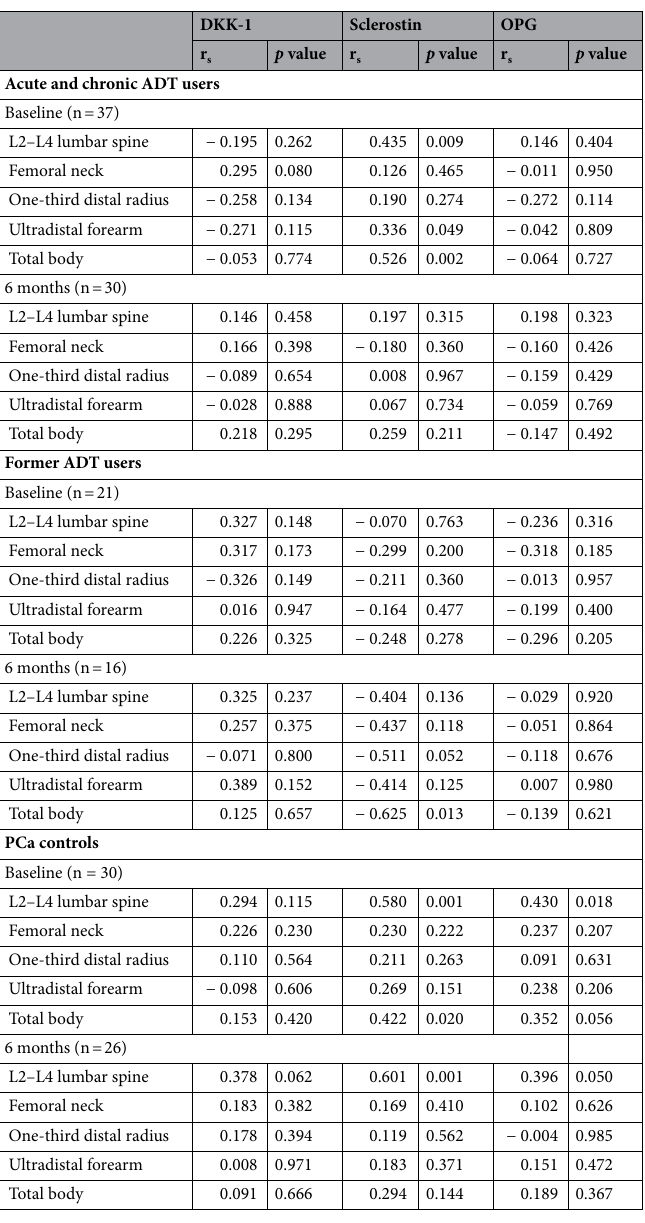
Table 4. Correlation between bone markers and BMD. DKK1 Dickkopf-1, OPG